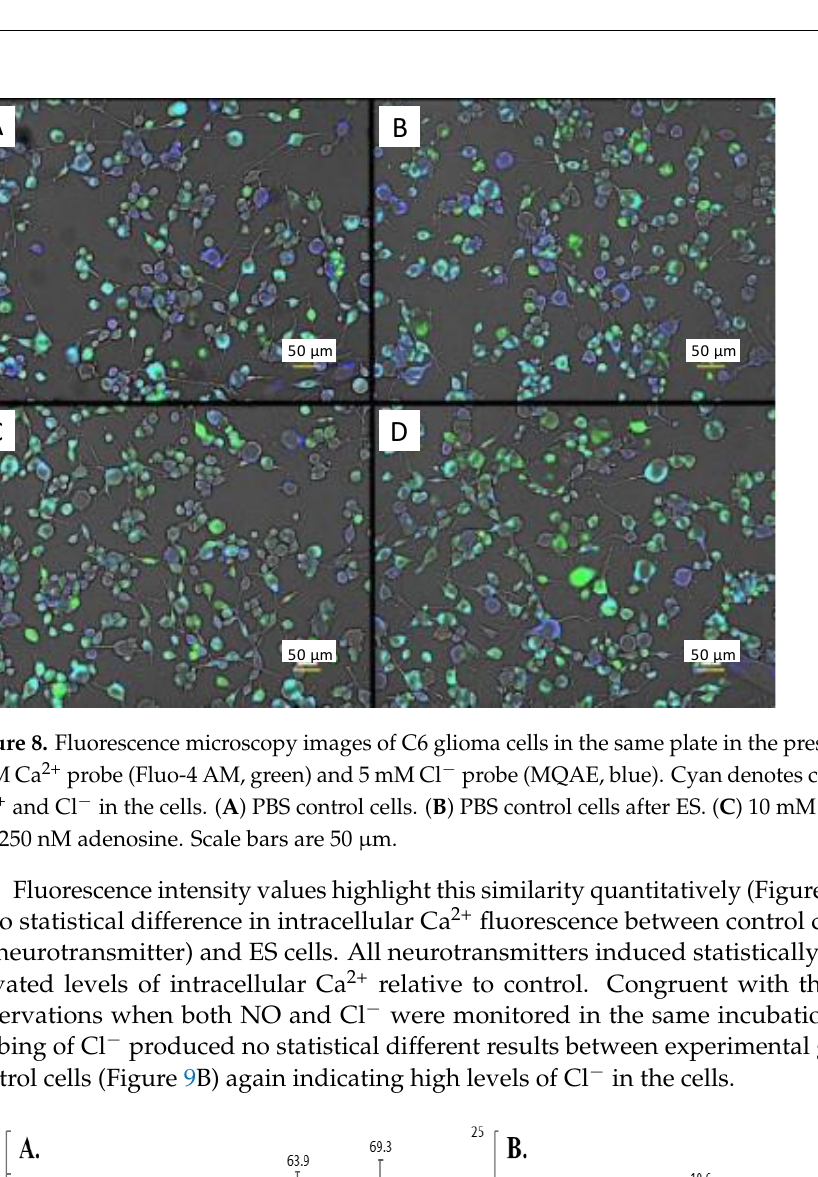
10 of 15 Figure 7. ( A ) Mean fluorescent intensity ± SD of DAF-FM (NO probe) averaged by condition group (Figure 2). All differences in mean intensities are significant except GABA vs. Glu by ANOVA with Tukey post hoc test ( p < 0.05). ( B ) Mean fluorescent intensity ± SD of MQAE (Cl − probe) averaged by condition group (Figure 2). No statistical differences were found between any of the groups. MQAE fluorescence probing of Cl − showed no statistical difference between experi- mental groups, although, addition of glutamate and GABA led to modest increases rela- tive to control cells. Fluorescence intensities (Figure 7B) from MQAE are relatively low, compared to DAF-FM signal intensities, implying large amounts of Cl − are retained in the